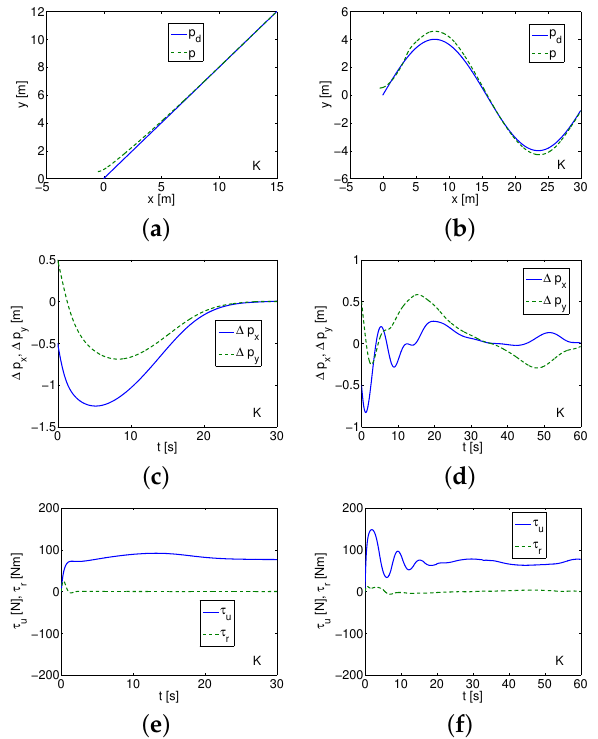
Figure 4. Simulation results for Kambara (SMC/backstepping)—linear and sine trajectory. ( a , b ) Desired and realized trajectory; ( c , d ) position errors; ( e , f ) applied forces/torques.